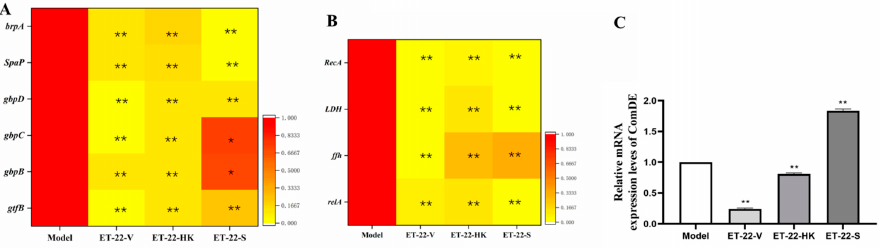
Figure 4. Effects of L. paracasei ET-22 on gene expressions involved in the adhesive, acid-resistant, acidogenic, and quorum-sensing (QS) qualities of S. mutans . ( A ) A heatmap of the relative gene-expression-levels of proteins involving adhesions and the formation of the S. mutans biofilm, including brpA , SpaP , gbpD , gbpC , gbpB , and gtfB . Means ± SEM are shown ( n = 6). * p < 0.05, ** p < 0.01, vs . Model group. ( B ) A heatmap of the relative gene-expression-levels of proteins involved in the acid production and acid tolerance of S. mutans , including RecA , LDH , ffh , and relA . Means ± SEM are shown ( n = 6). ** p < 0.01, vs . Model group. ( C ) The gene-expression-levels of comDE in the QS system of S. mutans . Means ± SEM are shown ( n = 6). ** p < 0.01, vs . Model group.